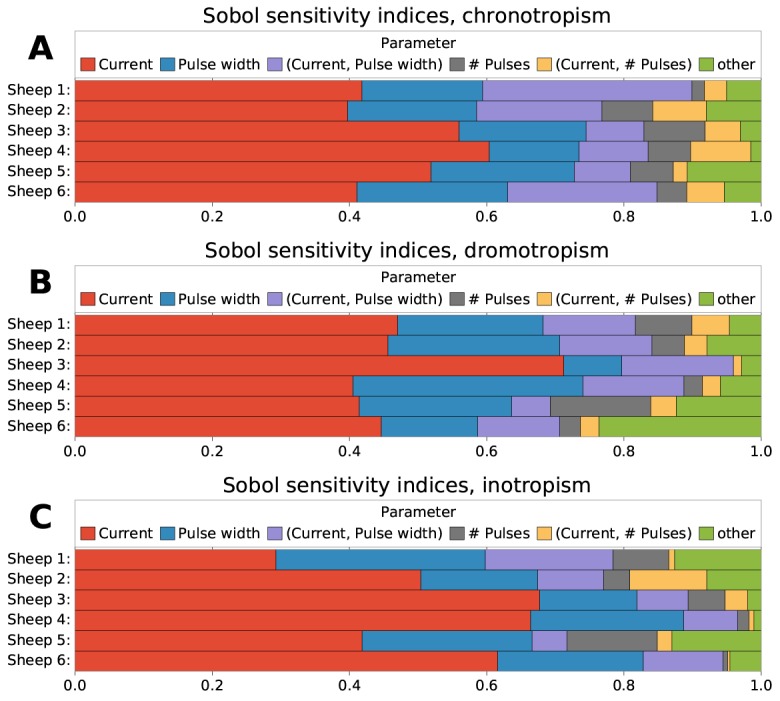
Relative sensitivity of each VNS parameter and VNS parameter combination, according to Sobol’s first order and interaction indices.A) chronotropic effect, B) dromotropic effect and C) inotropic effect. Only the five largest indices are shown, while the rest are summed together (“other”).